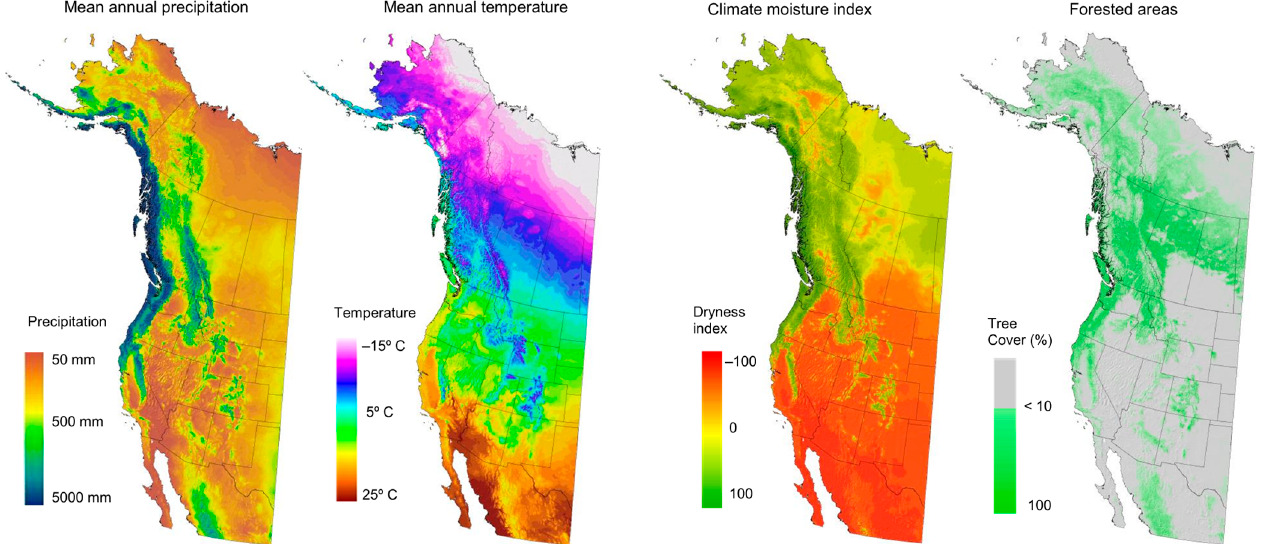
Figure 1. Climatology and tree cover of western North America. The climate moisture index (CMI) is estimated from precipitation, minus a latitude and temperature-driven monthly potential evapo- transpiration estimate. Remotely-sensed tree cover (MODIS) approximately follows the CMI-in- ferred forest–grassland transition.